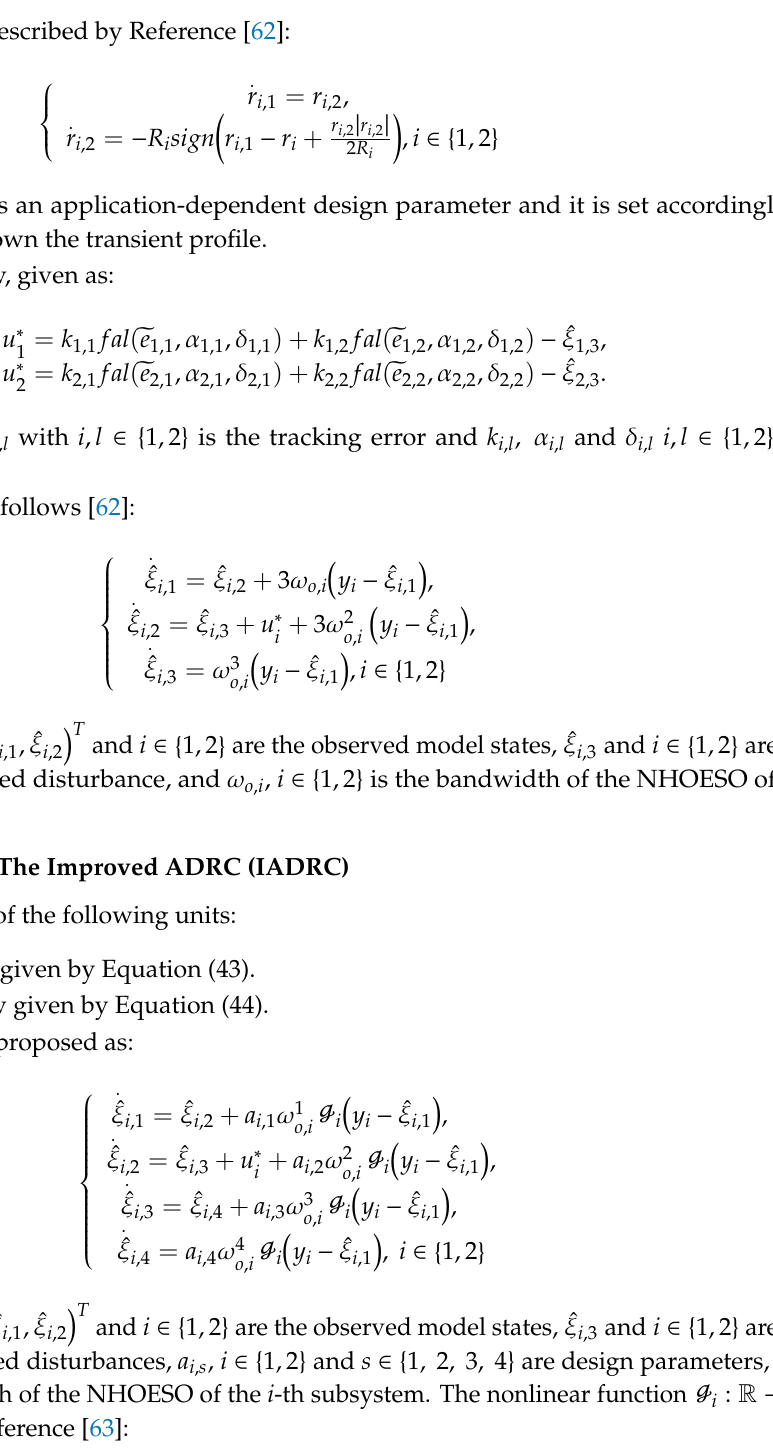
Figure 5. The proposed decentralized ADRC control scheme, where each ADRC block involves a SISO connection of TD, NLSEF, and ESO, as in Figure 1.